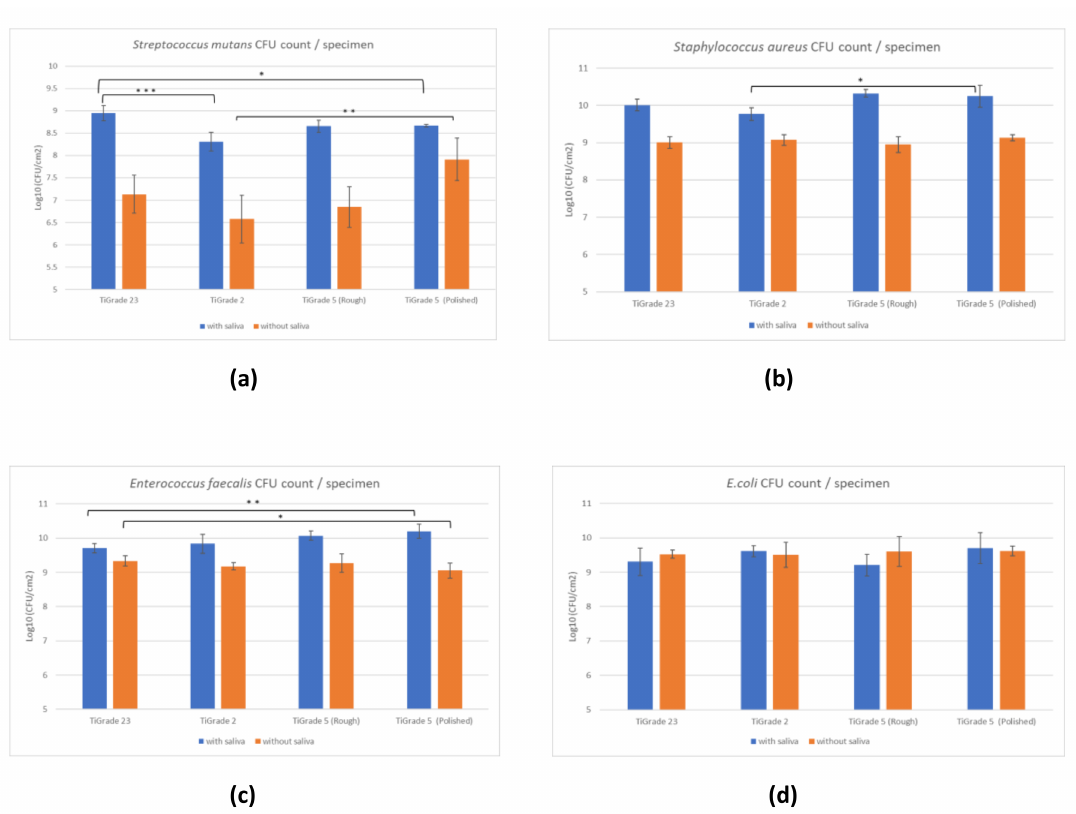
Figure 2. Comparison of colony-forming unit (CFU) count of ( a ) S. mutans , ( b ) S. aureus , ( c ) E. faecalis and ( d ) E. coli on different titanium implant materials: with saliva treatment (blue) and without saliva treatment (orange). Statistical difference between materials is marked with lines * p < 0.05, ** p < 0.01, *** p <